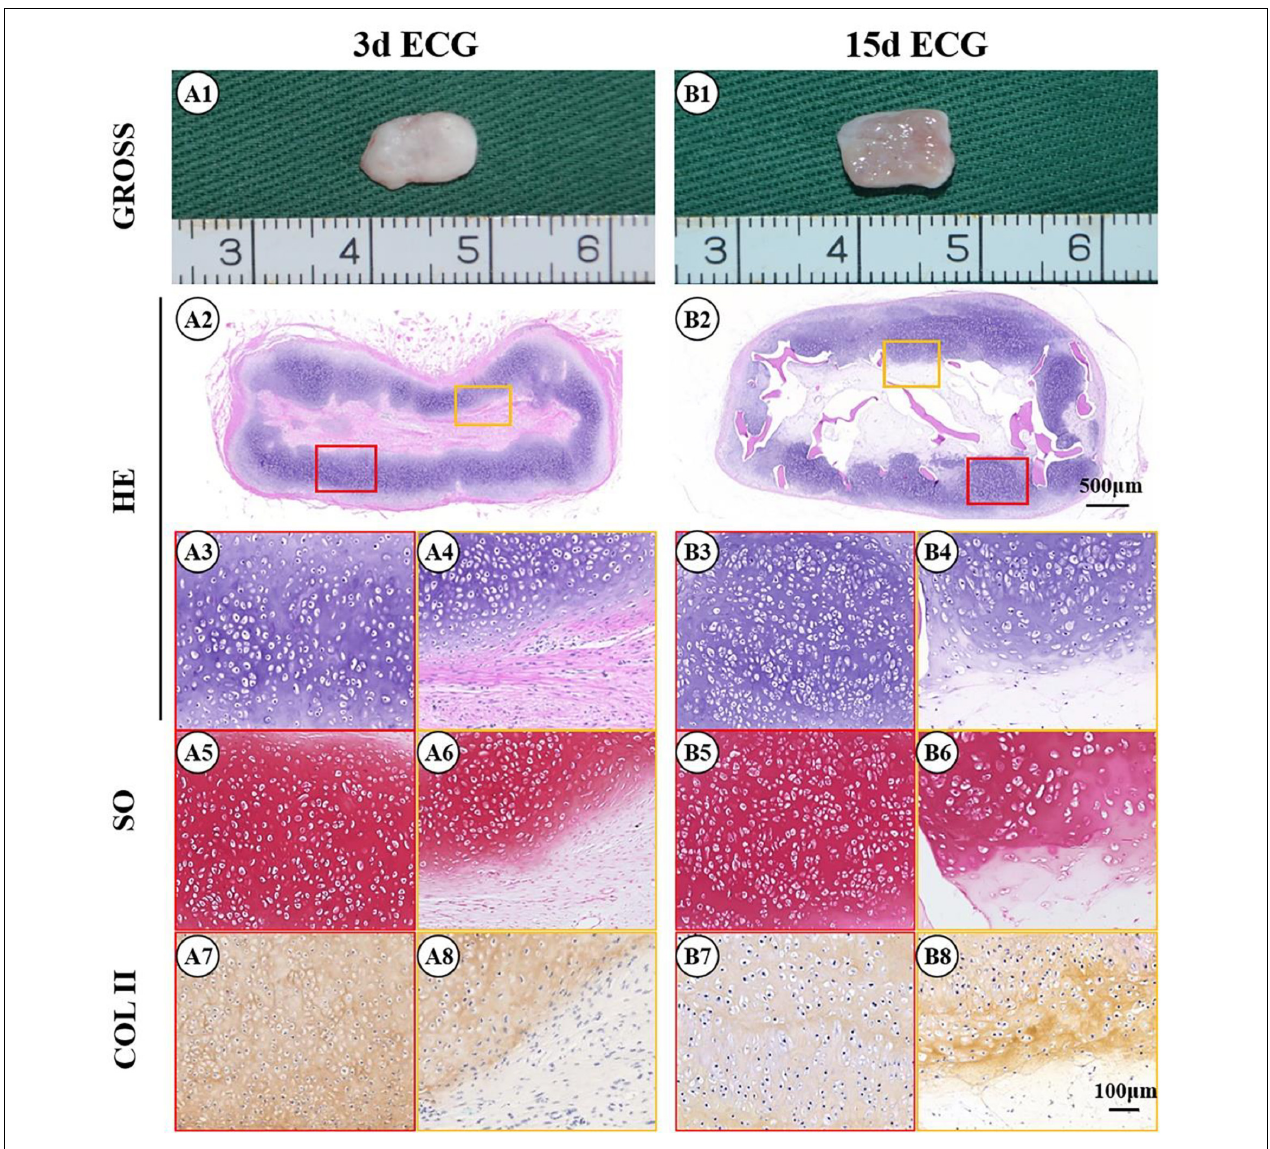
FIGURE 4 | Gross view and histological examination of the cartilage regenerated by goat engineered cartilage gel (ECG) after 12 weeks in vivo in autologous goat. Gross view, HE, Safranin-O, and collagen II immunohistochemical staining of 3 d ECG–decalcified bone matrix (DBM) (A1–A8) and 15 d ECG–DBM (B1–B8) constructs. The red box represents the mature cartilage-like tissue areas, and the orange box represents immature cartilage-like